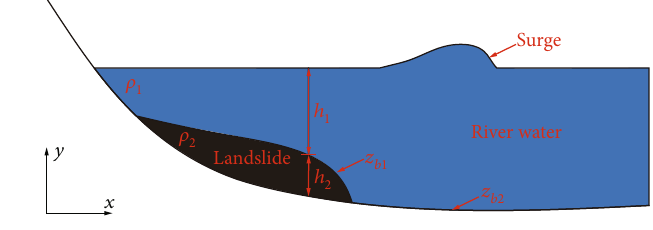
Figure 1: Sketch of the numerical